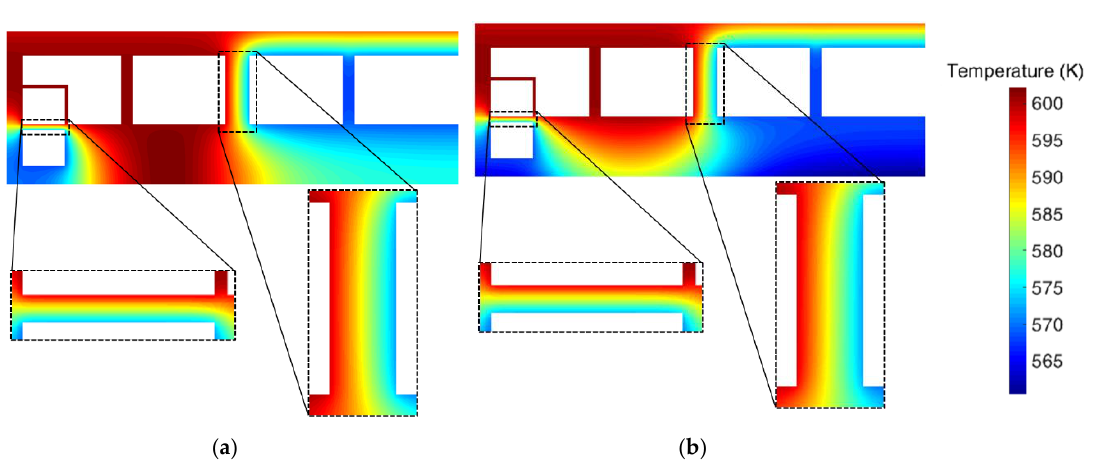
Figure 7. Two-dimensional (2D) temperature map in the manifold region: ( a ) with adiabatic wall; ( b ) with radiative heat transfer. The insets show the detail of the regions of interest.